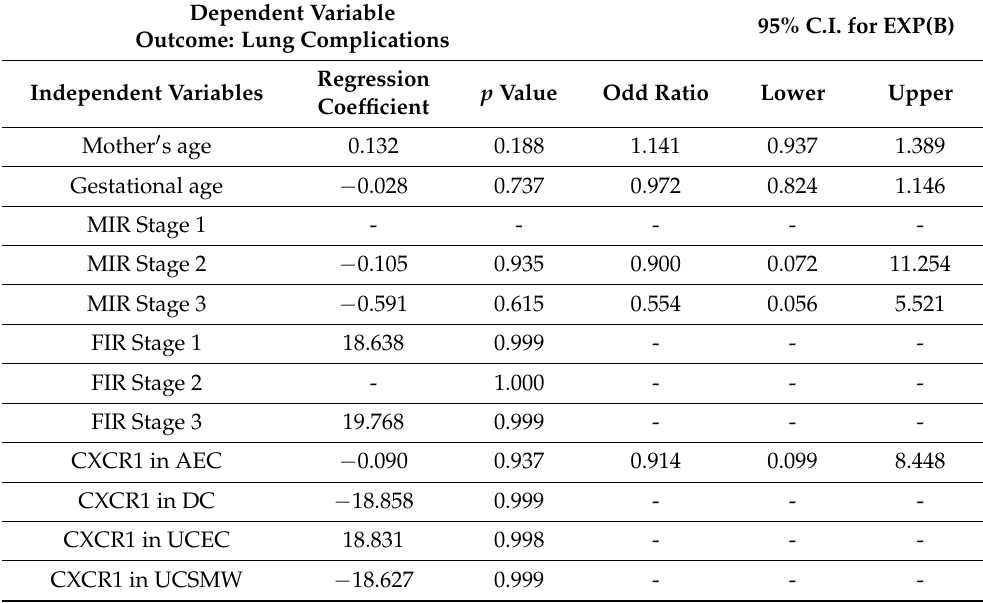
Table 5. Logistic regression analysis with lung complications as the dependent variable against various independent variables in